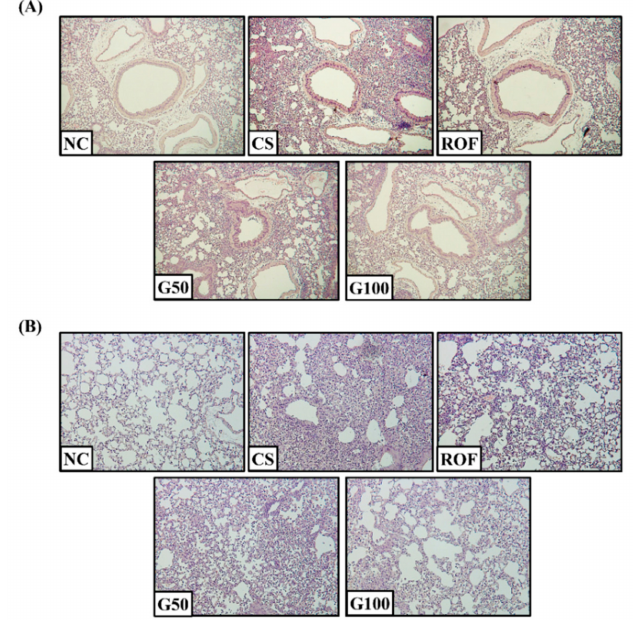
Figure 2. GGWE attenuate inflammatory cell infiltration in H&E staining. ( A ) Peribronchial region, ( B ) alveolar region. NC, non-treated mice; CS, CS and LPS exposure mice; ROF, roflumilast 10 mg/kg and CS and LPS exposure mice; G50, GGWE 50 mg/kg and CS and LPS exposure mice; G100, GGWE 100 mg/kg and CS and LPS exposure